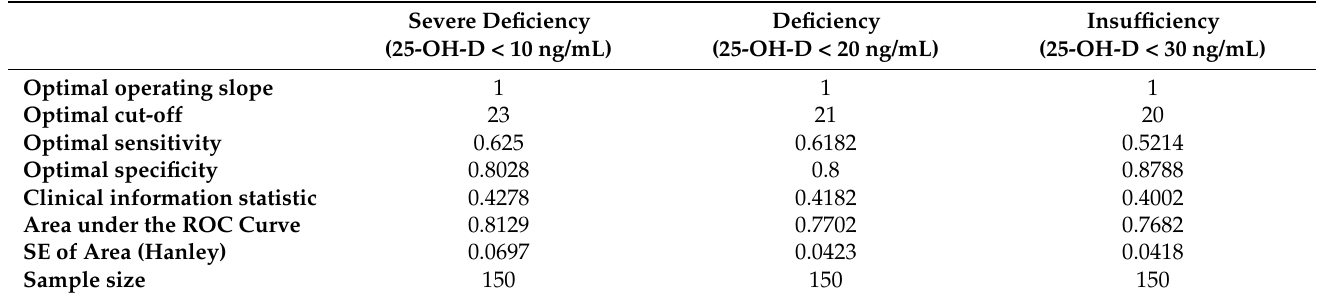
Table 3. Summary of ROC curve analysis results using the three reference variables.